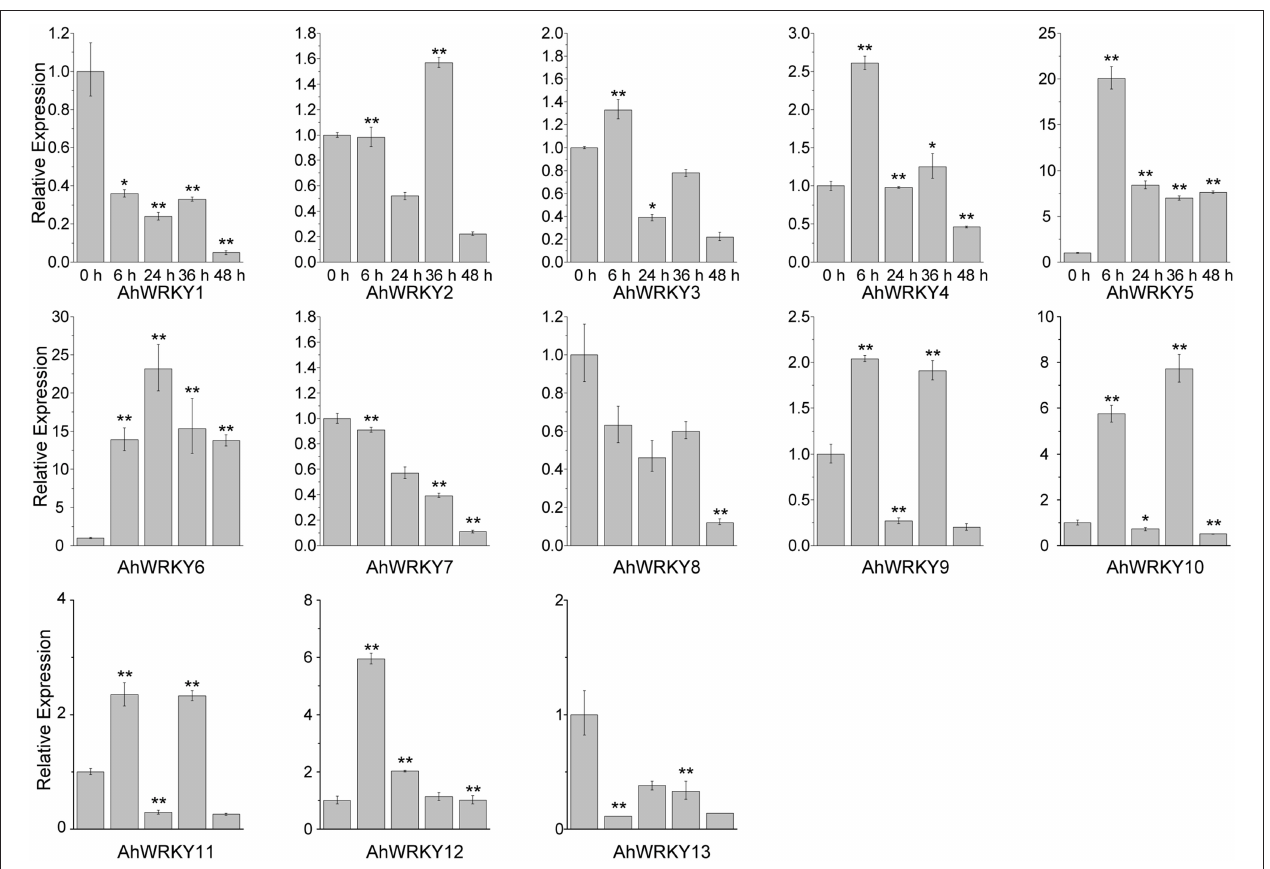
FIGURE 5 | The expression pattern of AhWRKY genes after MeJA treatment. The Y-axis indicates the relative expression level; X-axis (0, 6, 24, 36, and 48 h) indicated hours of MeJA treatment. The standard errors are plotted using vertical lines. * and ** mean significant difference at P < 0.05 and P < 0.01,